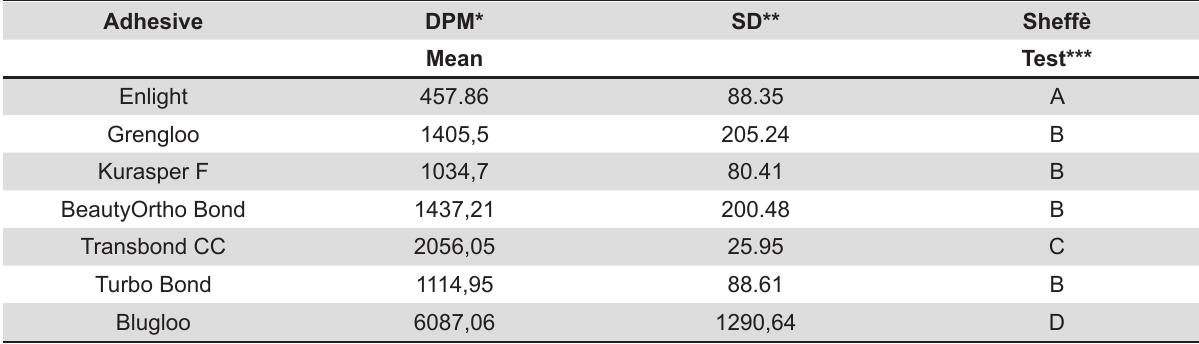
* DPM (Desintegration per Minute) ** SD (Standard Deviation) *** Composites orthodontic resins with different letters are significantly different from each other. Table 2- Quantitative test to S. sobrinus by radiolabeled ( 3 H)